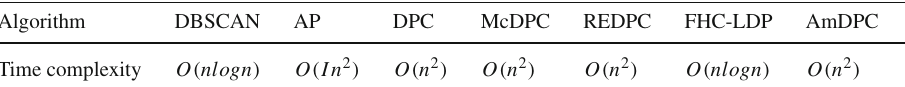
Table 4 Time complexity of different algorithms